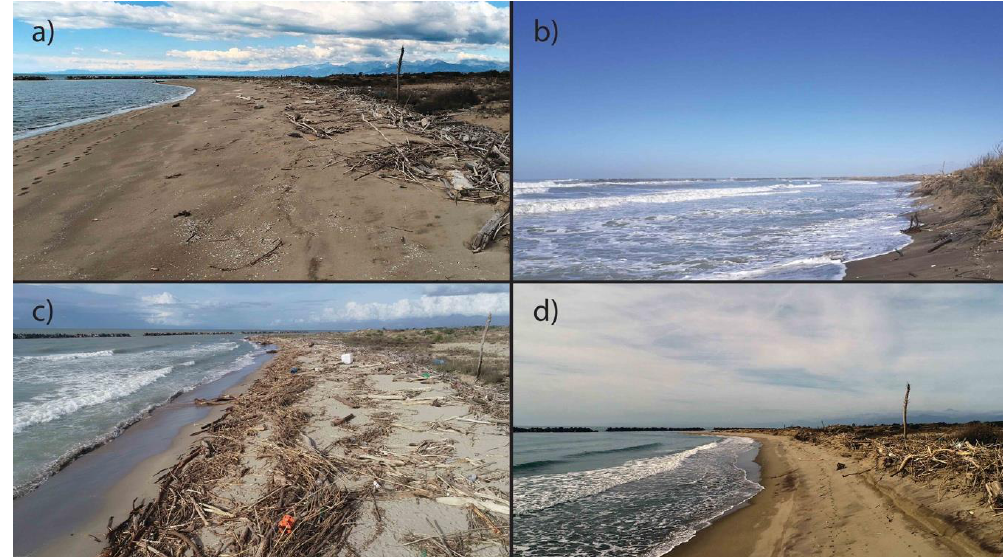
Figure 12. ( a ) The beach before the sea storm of 20/11/2019 (normal conditions). ( b ) The beach during the storm. ( c ) The beach 3 days after the storm. ( d ) The beach 10 days after the storm. At the time of the last monitoring (17 January 20120, i.e., 32 days after the storm) the beach was returned almost to its normal condition and conformation.